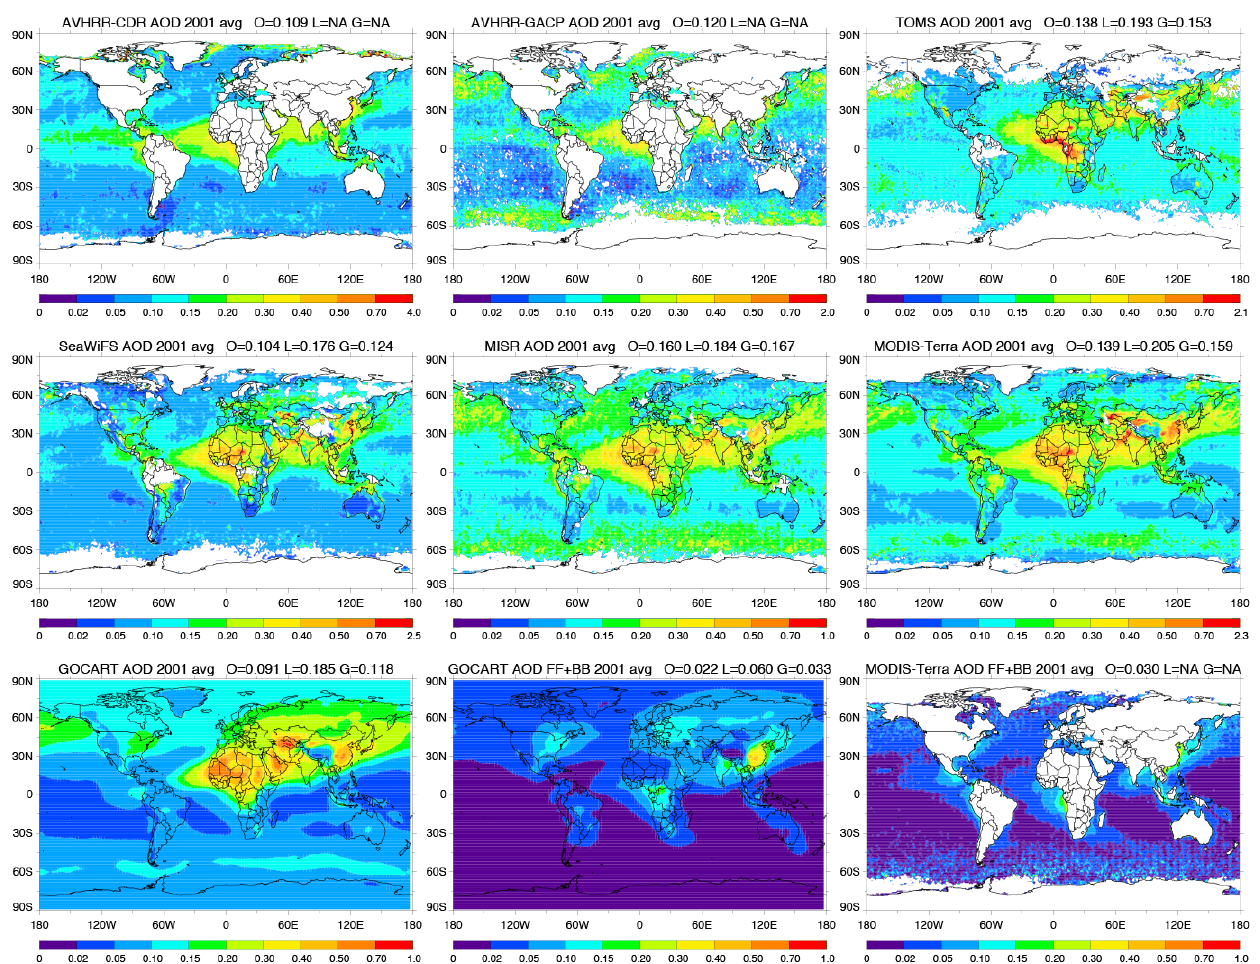
Fig. 4. Spatial distributions of 2001 annual average AOD from satellite retrieval products and GOCART model. From left to right, 1st row: AVHRR-CDR (left), AVHRR-GACP (middle), TOMS (right); 2nd row: SeaWiFS (left), MISR (middle), MODIS-Terra (right); 3rd row: GOCART-simulated total AOD (left) and FF + BB AOD (middle) and MODIS-derived FF + BB AOD (right). O, L, and G are for ocean, land, and global averages. White areas indicate no data. Annual average values over ocean (O), land (L), and globe (G) are shown on top of each panel (NA = not available) except the last one. These averages are obtained with the available data from each individual data set without matching their spatial availability, i.e., the area included in the average varies with data sets. (The color scale for the AOD panels is the same except the maximum values at the end of the highest color